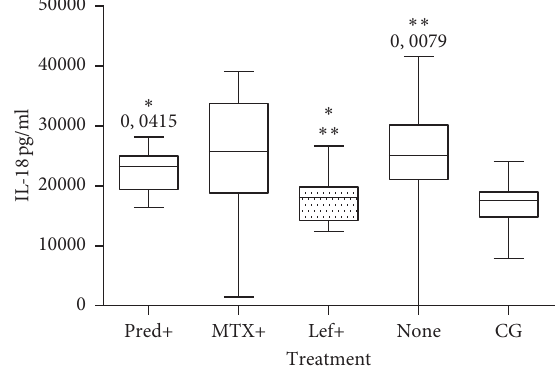
Figure 2: Cytokine levels of patients being treated or not. RA patients who underwent leflunomide treatment (Lef+ n � 7) exhibited lower serum IL-18 levels than patients who did not undergo any treatment ( n � 60) ( p � 0.0079) as well as those who were treated with prednisone (Pred+ n � 10) ( p � 0.0415). There was no statistical difference with the CG (Mann–Whitney test). MTX+ � methotrexate treatment n �